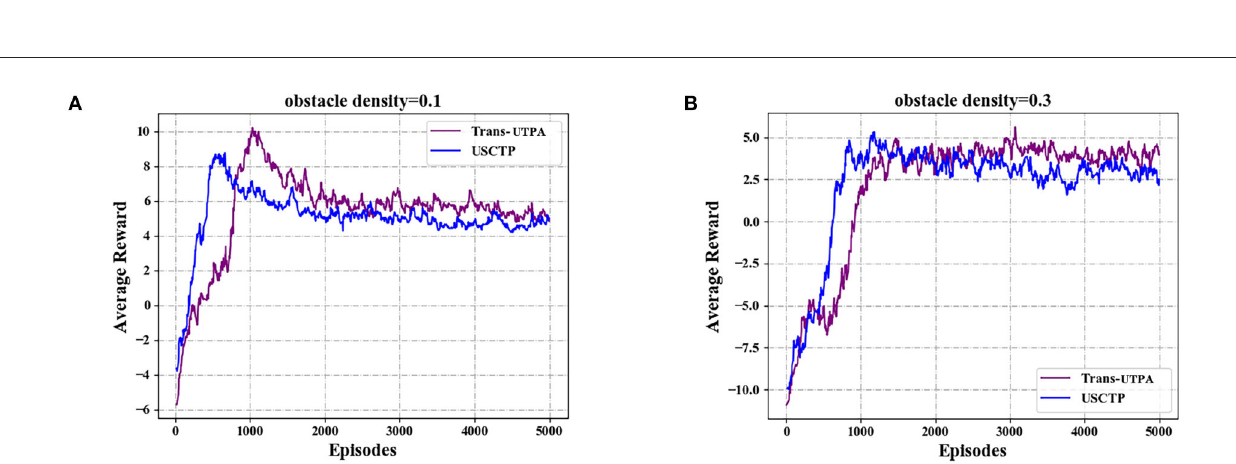
access more data acquisition areas during the process of going to the network communication area.When accessing the same number of target-POIs, the TUTPA algorithm takes less time than the A